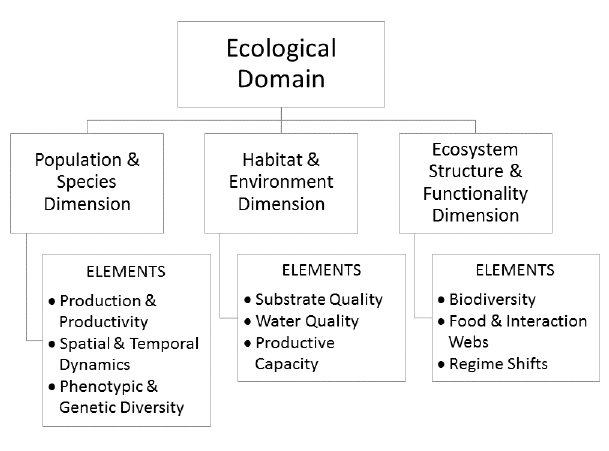
Fig. 2 . The ecological